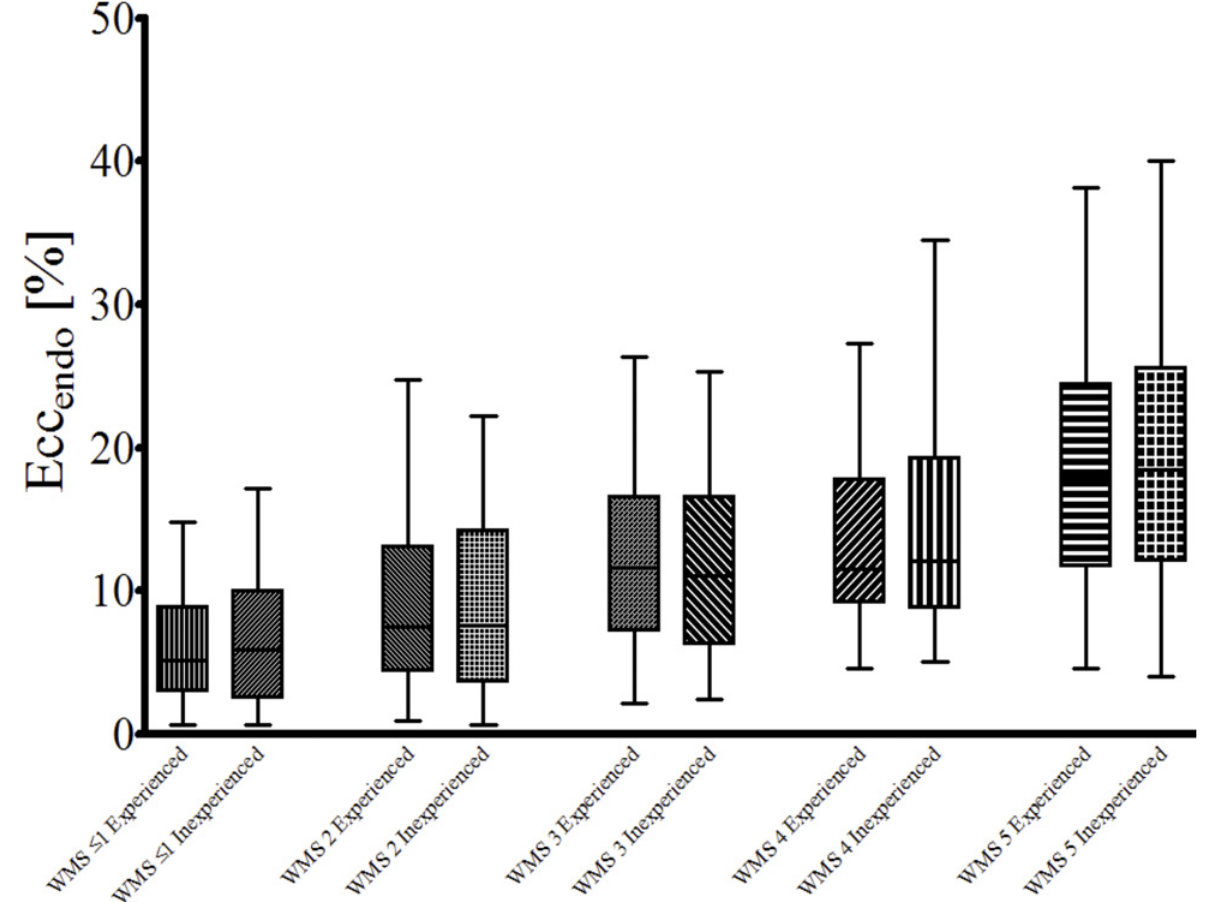
Fig 5. Relationship between strain values of the experienced and the inexperienced observer. Results show the strain values for (Ecc endo ) of the experienced and the inexperienced observer according to the visual reference standard as defined by the experienced observers